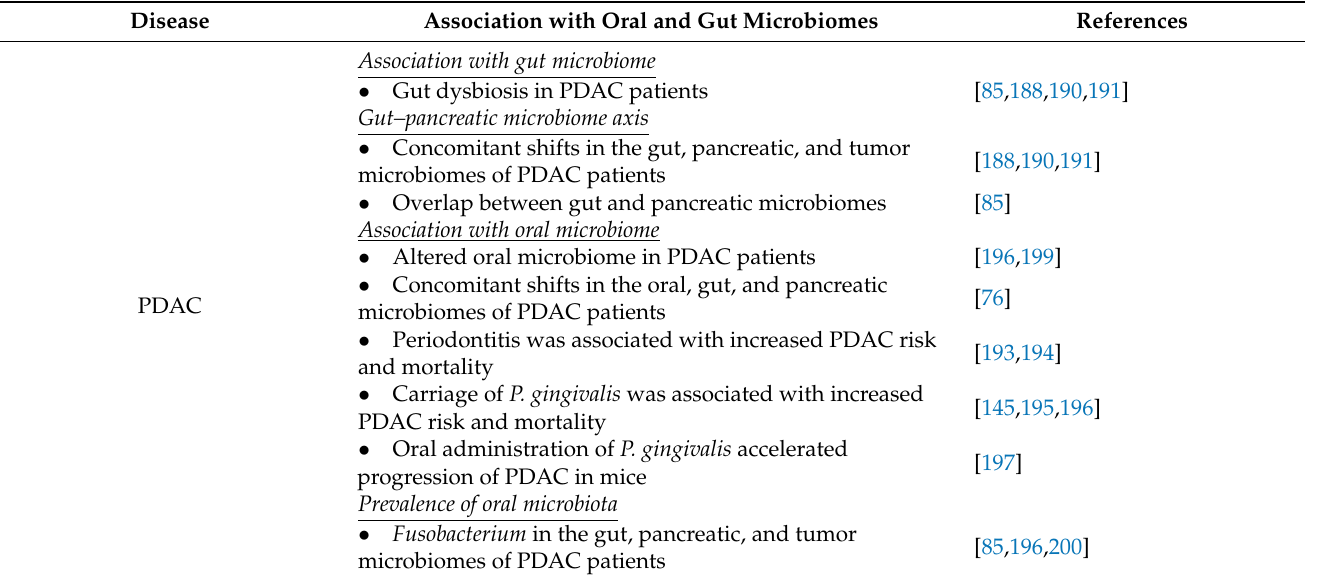
Table 3. Oral–gut microbiome axis in pancreatic